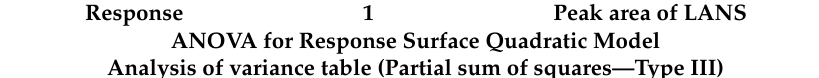
Table 9. ANOVA for response surface for peak area of